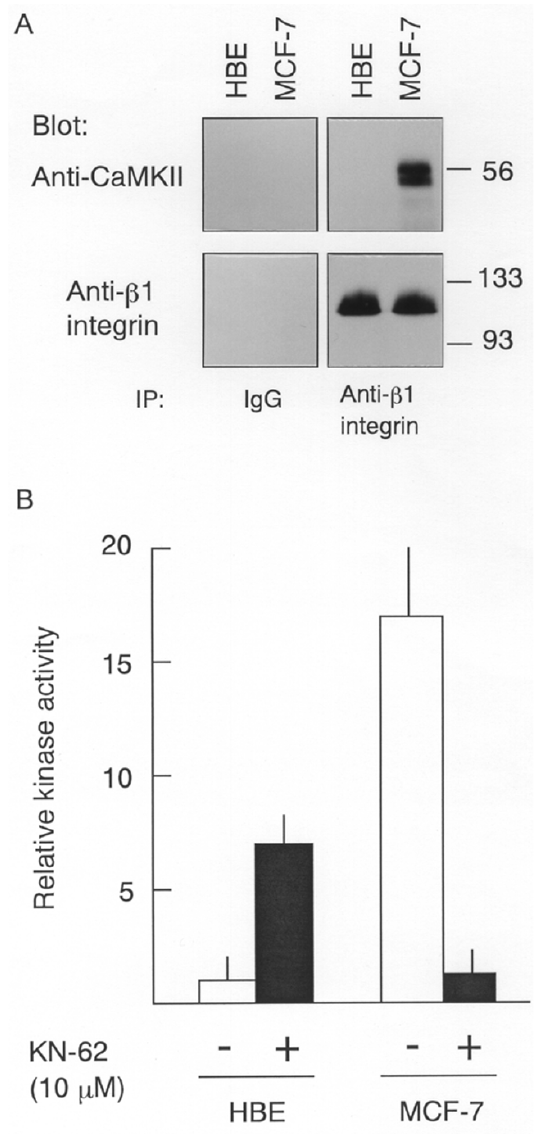
Figure 6 CaMKII binding to β 1 integrin in MCF-7 cells. (A) The β 1 integrin immunoprecipitates (IP) with the anti- β 1 integrin antibody or control IgG from HBE or MCF-7 cells were probed with antibody to all CaMKII isoforms or anti- β 1 integrin antibody. Molecular size markers are indicated at right in kDa. (B) The β 1 integrin immunoprecipitates from HBE or MCF-7 cells were incubated with the substrate pep- tide Autocamtide II, calmodulin, inhibitor peptides of PKA and PKC, and [ 32 P]ATP with (closed columns) or without (open columns) 10 µ M KN-62 at 30 ° C for 10 min. After sub- traction of the background, the activity was normalized to the amount of β 1 integrin and expressed relative to that of the β 1 integrin immunoprecipitates from HBE cells without KN-62. Results represent the mean ± S.D. (bars) of duplicate assays of three independent